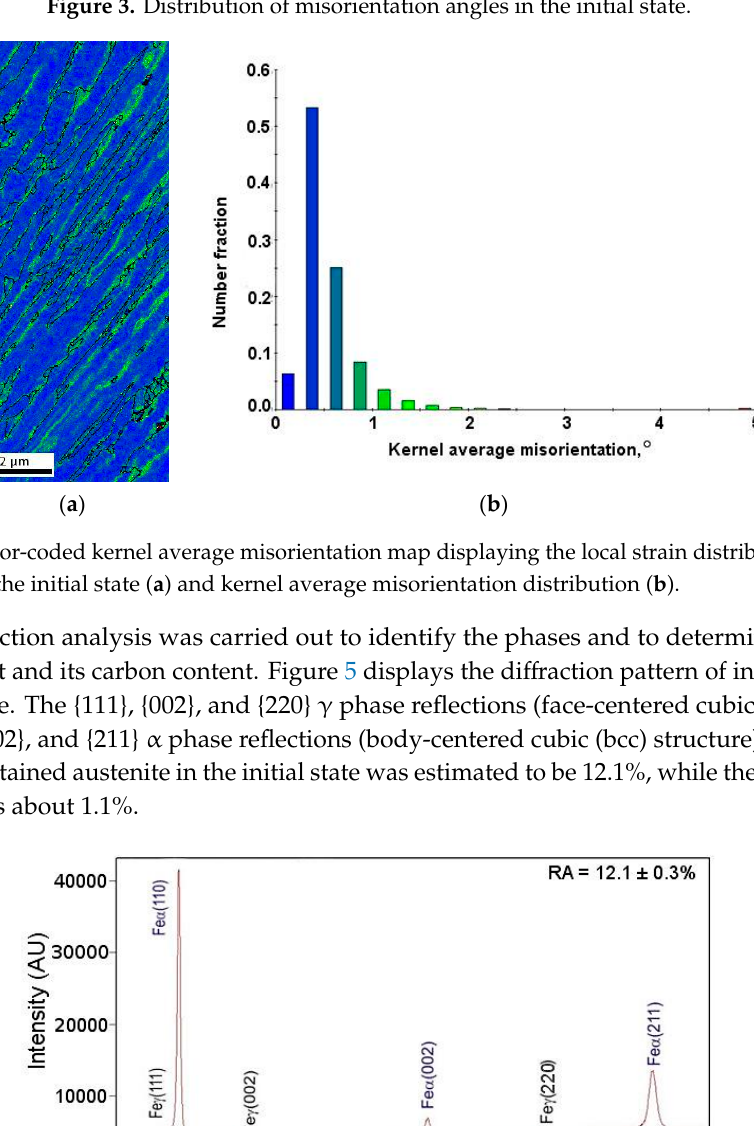
Figure 3. Distribution of misorientation angles in the initial state.